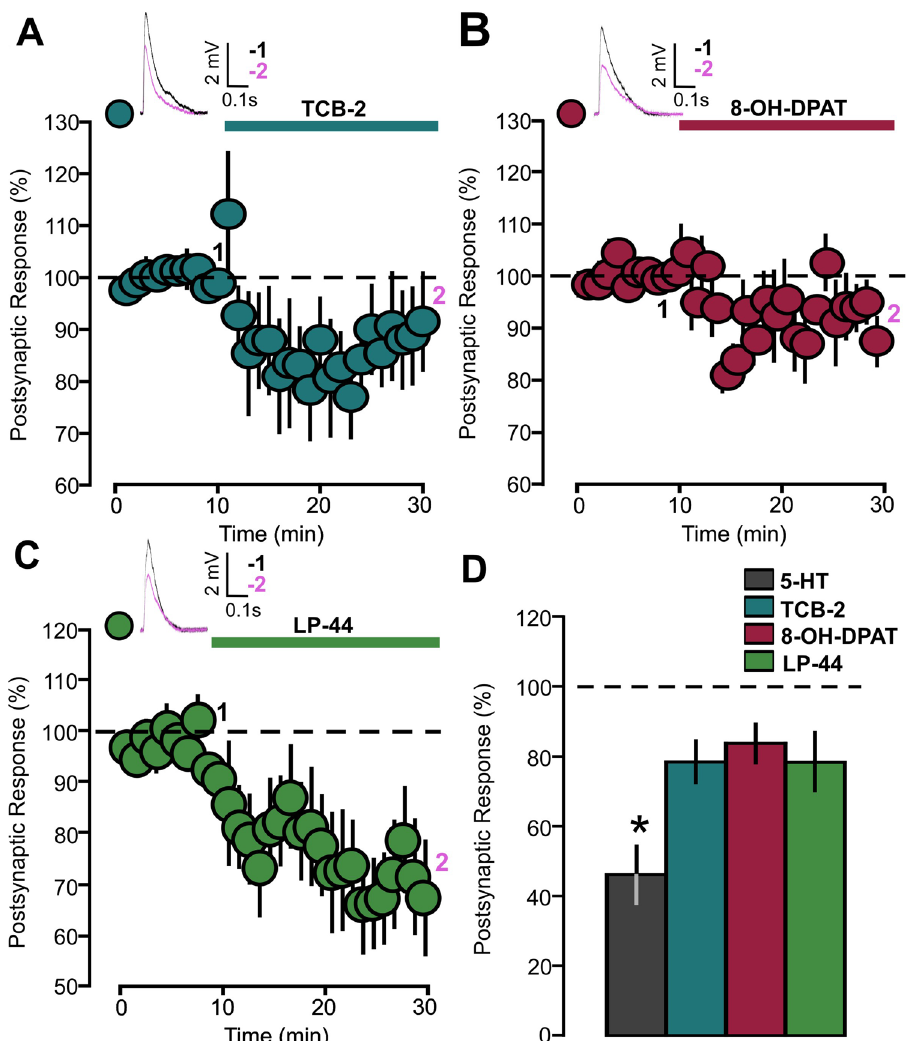
Figure 3. 5-HT 1A , 5-HT 2A and 5-HT 7 receptors agonists reduce the amplitude of synaptic responses. ( A ) The graph shows the EPSPs recorded in P14-16 animals before and during 5-HT 2A receptor agonist TCB-2 (10 µM) bath application. The EPSPs were normalized to the mean of responses recorded during the baseline. Traces show the results of a representative experiment with the average of postsynaptic responses recorded before (1: 5 to 10 min, black line) and after (2: 25 to 30 min, magenta line) application of TCB-2. ( B ) The graph shows the EPSPs recorded in P14-16 animals before and during 5-HT 1A receptor agonist 8-OH-DPAT (1 µM) bath application. The EPSPs were normalized to the mean of responses recorded during the baseline. Traces show the results of a representative experiment with the average of postsynaptic responses recorded before (1: 5 to 10 min, black line) and after (2: 25 to 30 min, magenta line) application of 8-OH-DPAT. ( C ) The graph shows the EPSPs recorded in P14-16 animals before and during 5-HT 7 receptor agonist LP-44 (2 µM) bath application. The EPSPs were normalized to the mean of responses recorded during the baseline. Traces show the results of a representative experiment with the average of postsynaptic responses recorded before (1: 5 to 10 min, black line) and after (2: 25 to 30 min, magenta line) application of LP-44. ( D ) Graph showing the effects of 5-HT and